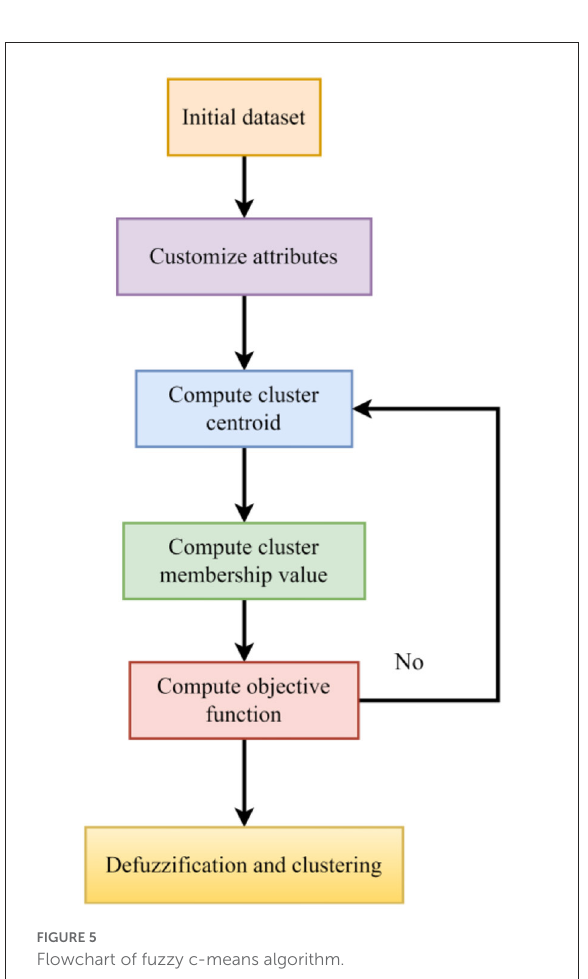
test instances ought to be computed in order to find the k nearest neighbors (63).